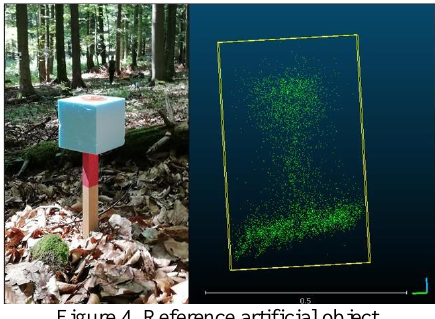
Figure 4. Reference artificial object.